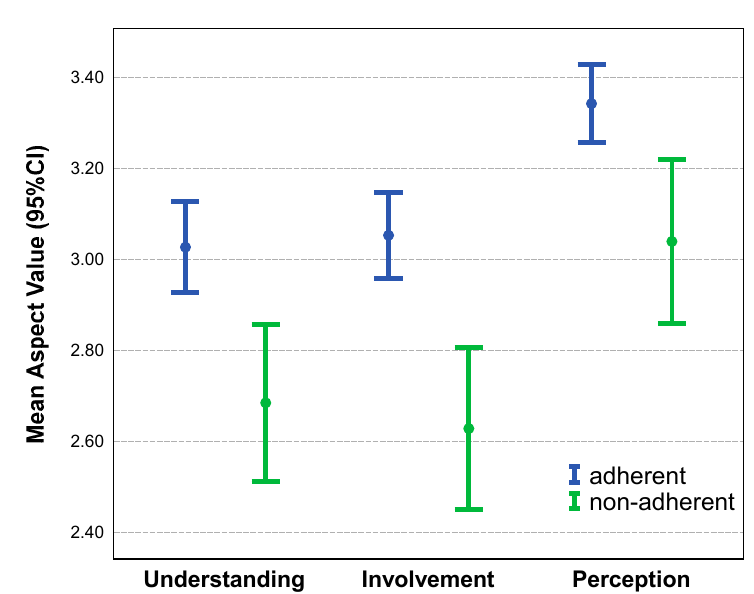
Figure 2. Mean aspect values (incl. 95% CI) by adherent and non-adherent patients measured on a 1–4 Likert scale (1 = weak, 4 = very strong).